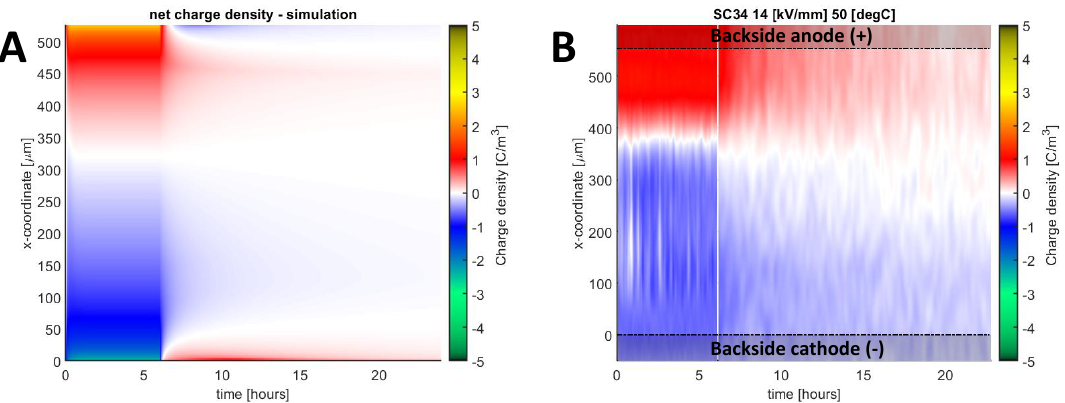
Figure 14. Colormap of net charge density in simulation ( A ) and measurement ( B ) for sample SC-34 subjected to + 7.5 kV polarization at 50 °C.